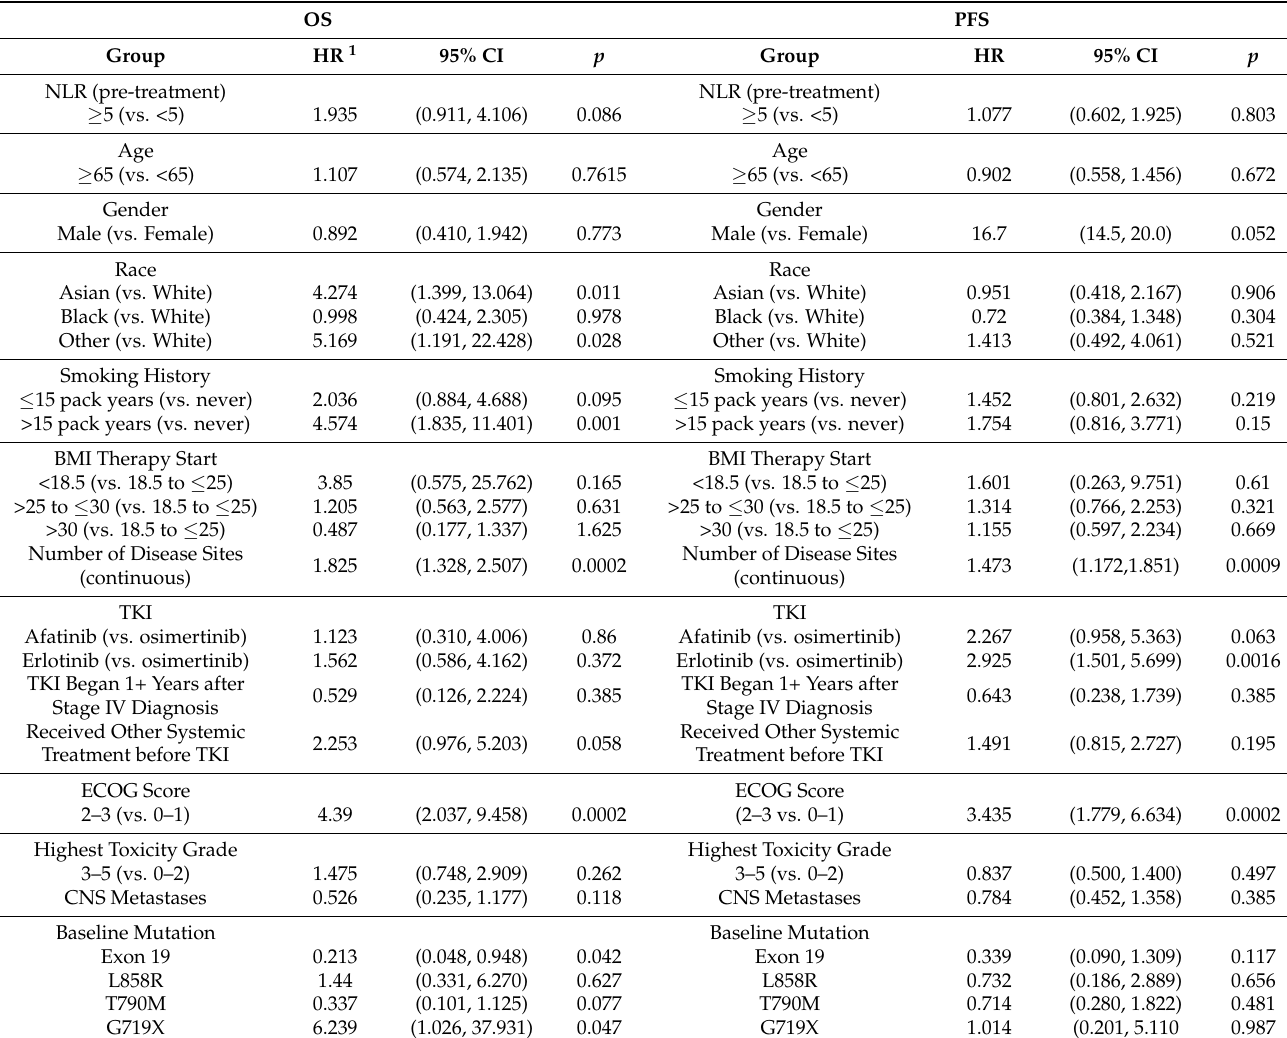
Table 4. Multivariable Cox regression analysis comparing impact of baseline characteristics on overall survival (OS) and progression free survival (PFS) at treatment